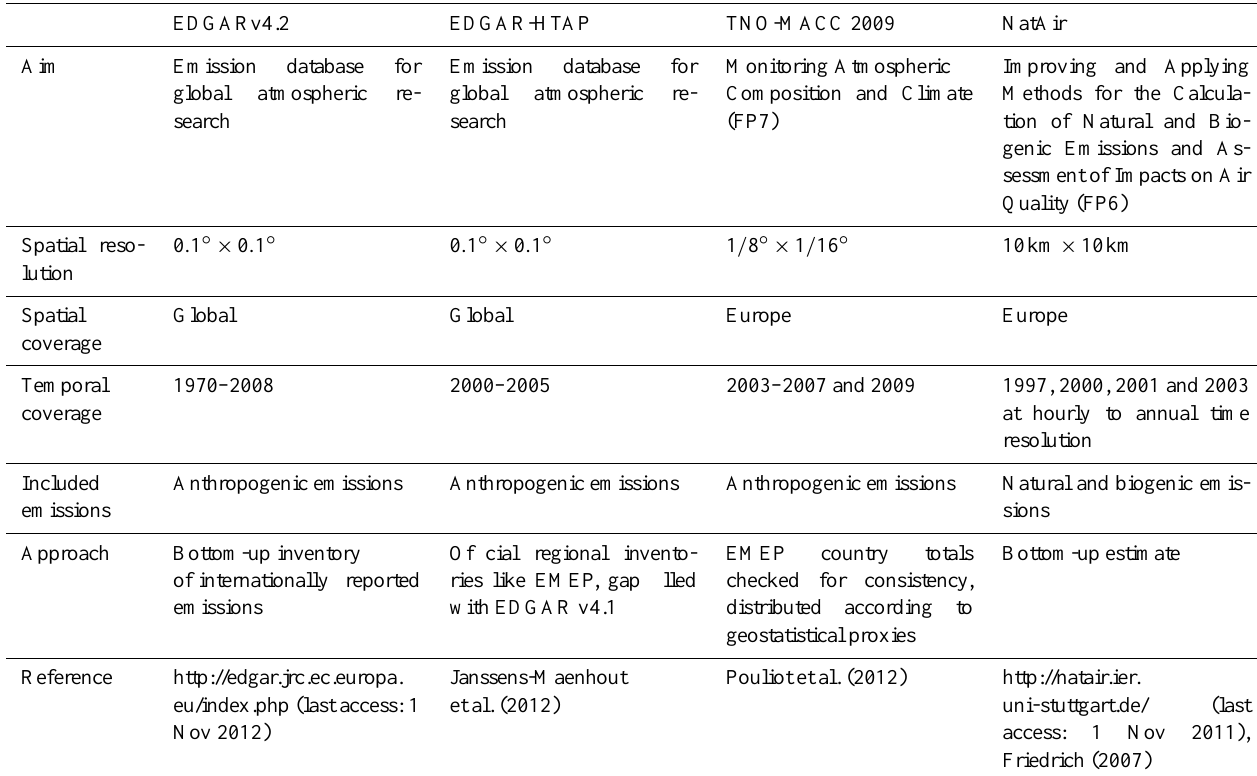
Table 1. Existing high-resolution CH 4 inventories that include